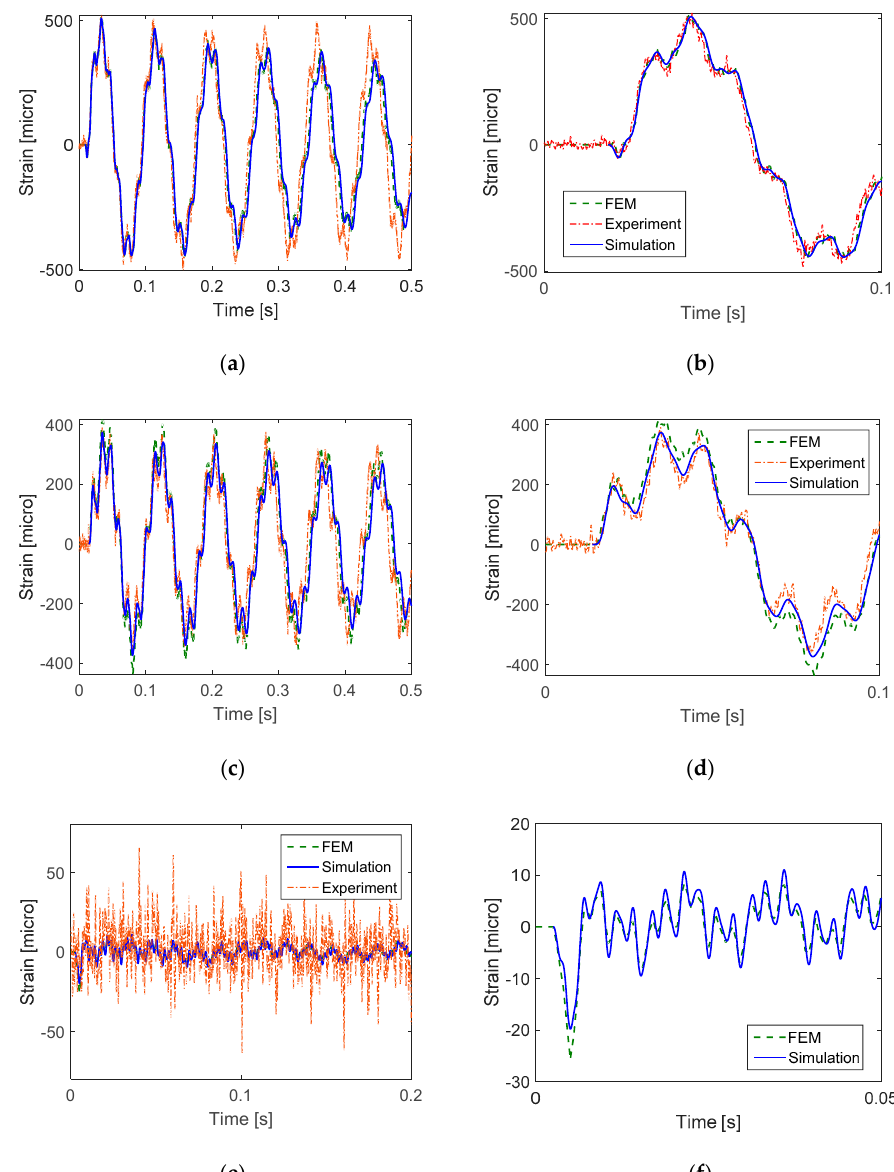
Figure 7. Strain measured at 70 mm from the fixed end for three impact locations. ( a , b ) Impact at location 1; ( c , d ) Impact at location 2; ( e , f ) Impact at location 3.